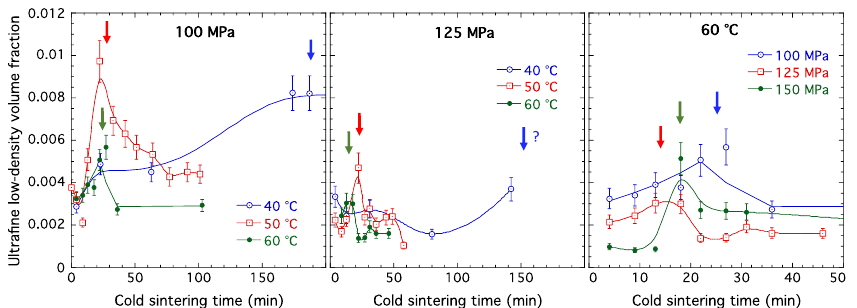
Figure 11. Ultrafine low-density volume fraction versus cold sintering time for 40 °C, 50 °C, 60 °C with p = 100 MPa and 125 MPa, and for p = 100 MPa, 125 MPa, 150 MPa at 60 °C. Lines are guide to the eye. Arrows indicate maxima in the volume fractions during each in situ study.